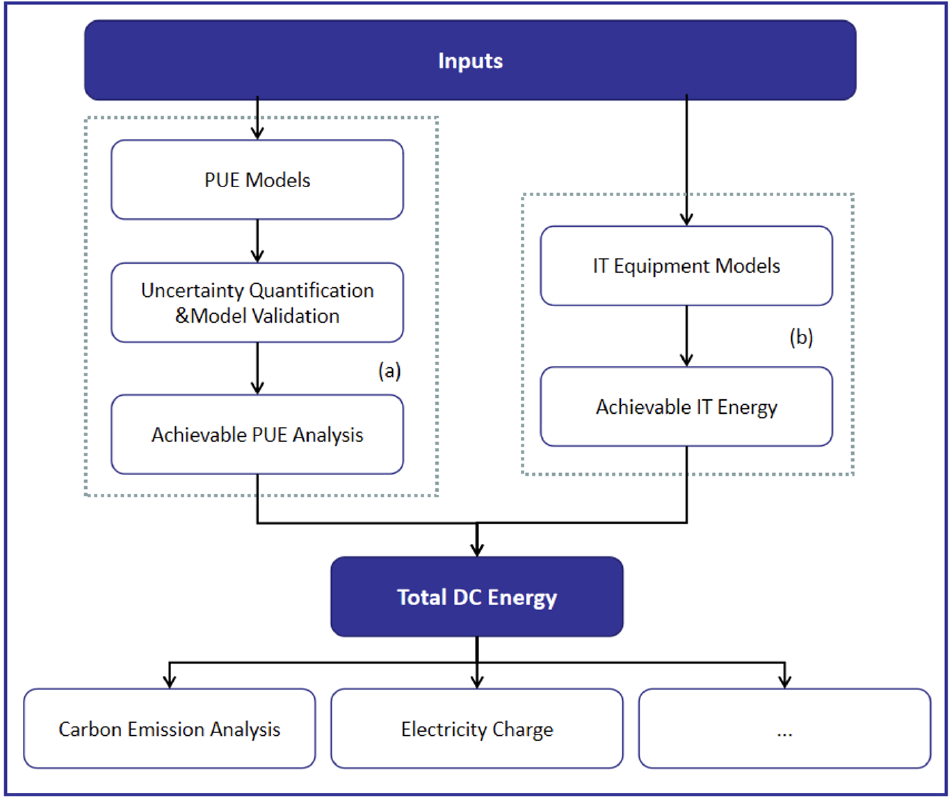
Figure 1. Data center global energy consumption prediction framework. ( a ) is used for PUE predic- tion, and ( b ) is applied for IT equipment energy